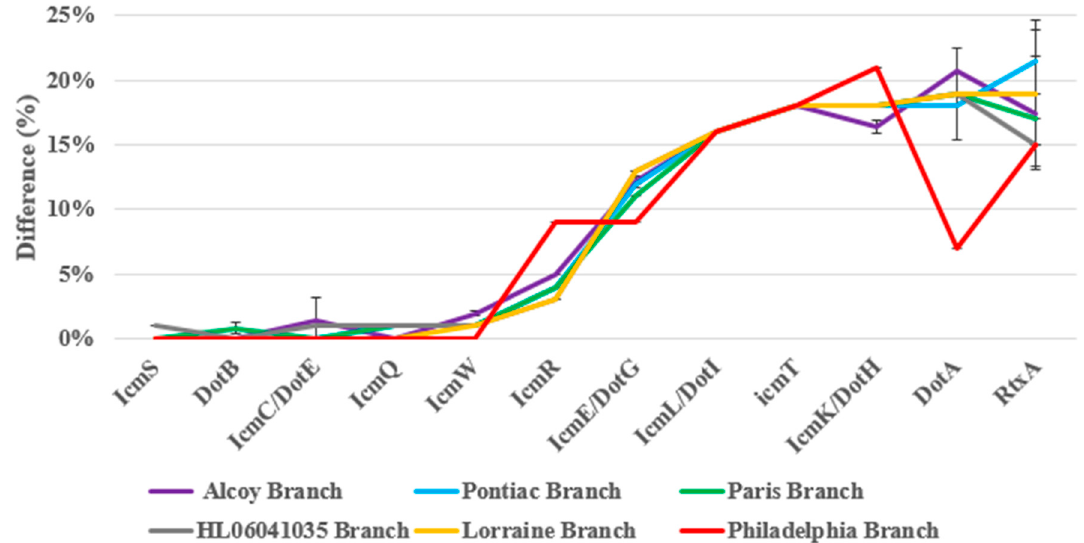
Figure 6. Amino acid differences of the fifty-five L. pneumophila strains genome sequenced in the pore-forming mediated cytotoxicity virulence genes, as identified by BLASTp search against the VFDB using L. pneumophila strain Philadelphia as the reference